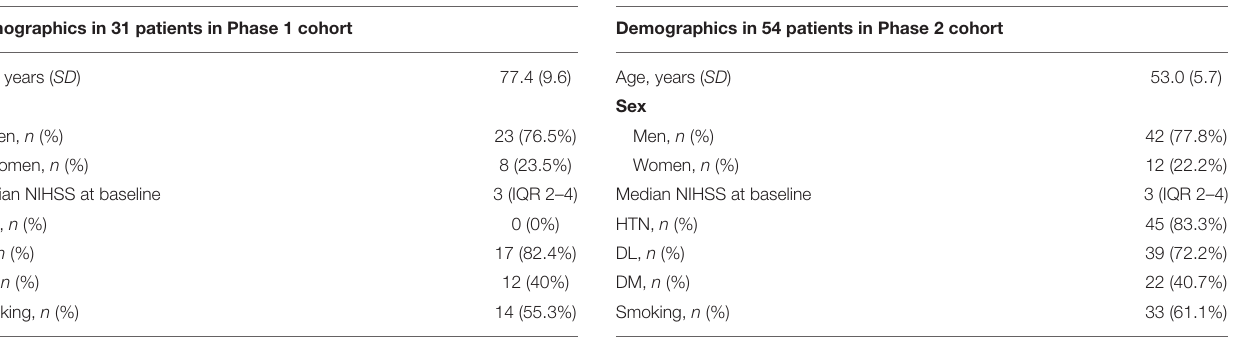
TABLE 1 | Demographic data of the 31 patients in the Phase 1